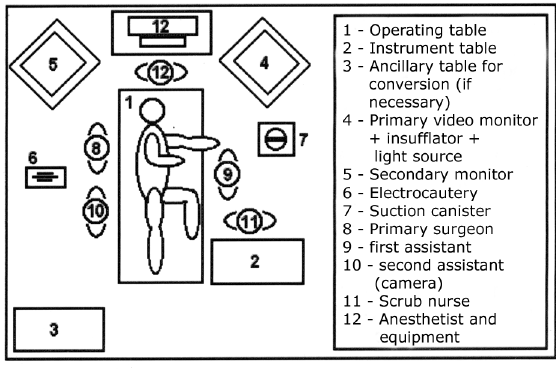
Figure 1 – Positioning of surgical staff in lumbar access.